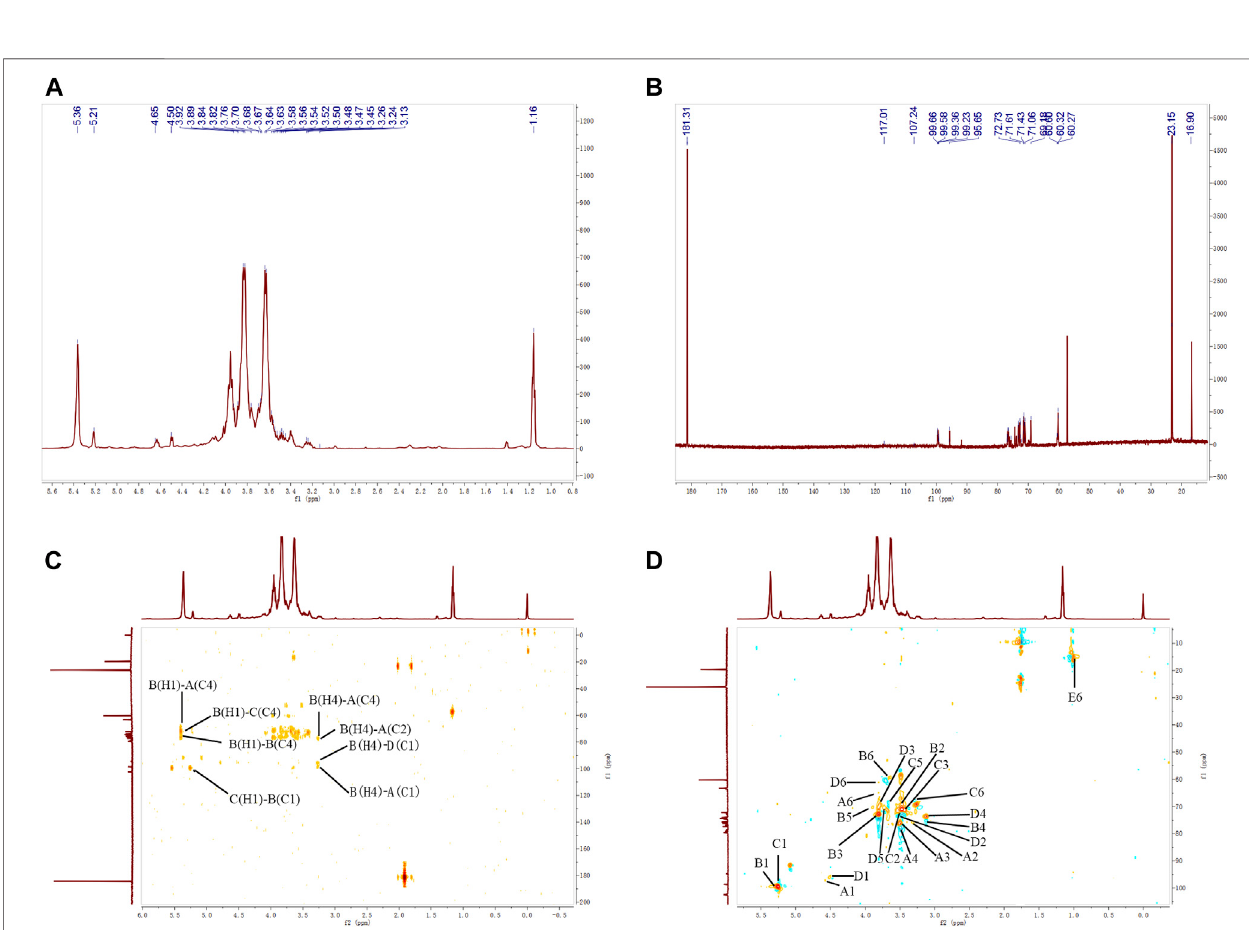
FIGURE 4 | 1 H – NMR (A) , 13 C – NMR (B) , HMBC (C) , and HSQC (D) spectra of APOS.